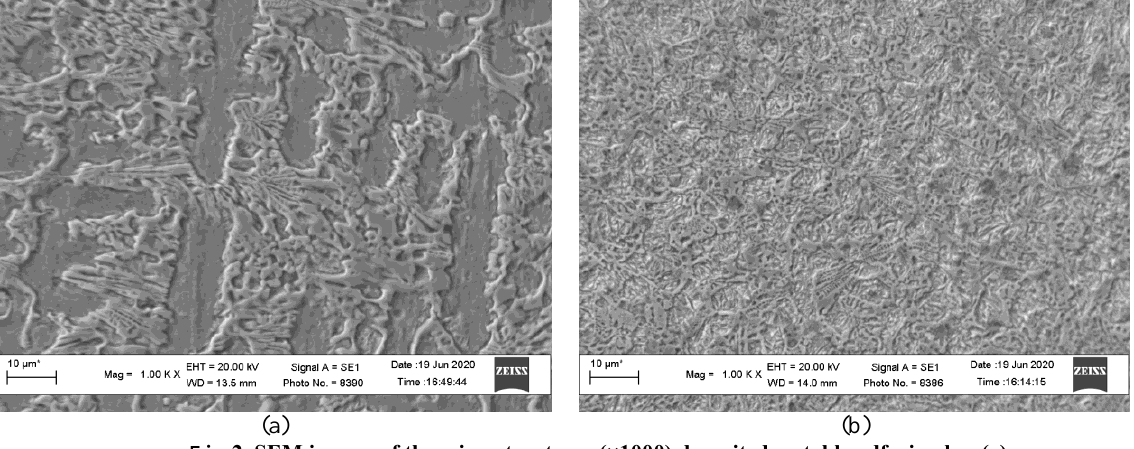
Fig. 2. SEM images of the microstructures (×1000) deposited metal hardfacing by: (a) FCAW-S-140Cr15TiSi1MnVB and (b) FCAW-S-110Cr4Cu5Ti1VB with exothermic addition (CuO‒Al).